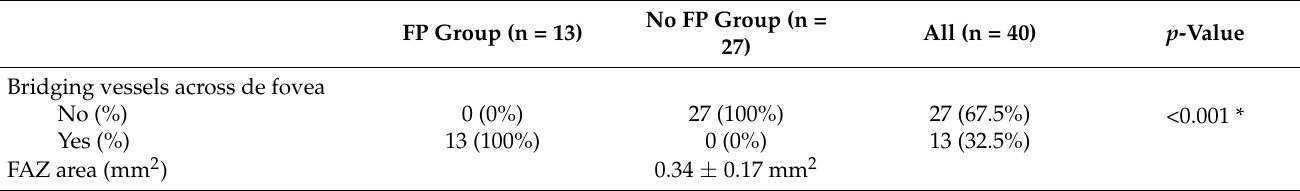
Table 5. OCT-A findings.